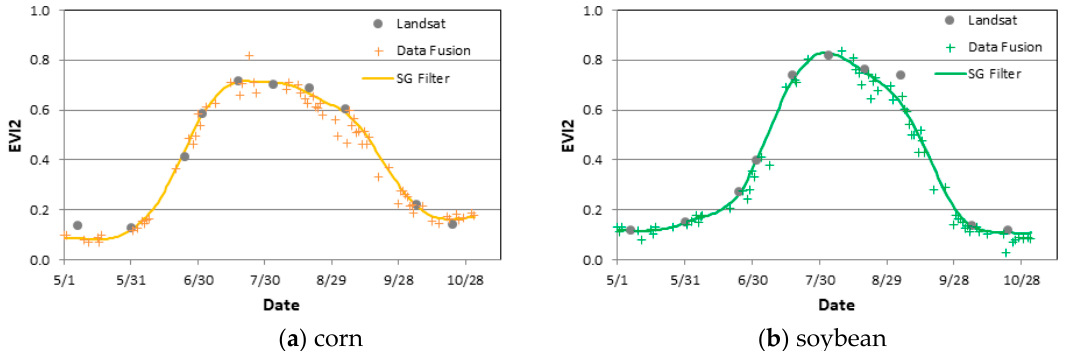
Figure 3. Two examples from Landsat, Landsat–MODIS data fusion, and the SG filter-smoothed result for corn ( a ) and soybean ( b ) in 2011 near the flux tower sites (yellow star in Figure 1). Maximum and cumulative (integral) NDVI and EVI2 metrics at a 30 m resolution for each year from 2001–2015 were computed using the smoothed and gap-filled daily VI time-series during the active growing months. The cumulative VIs were computed based on the cumulative period (from start to end date) and a base VI value as: